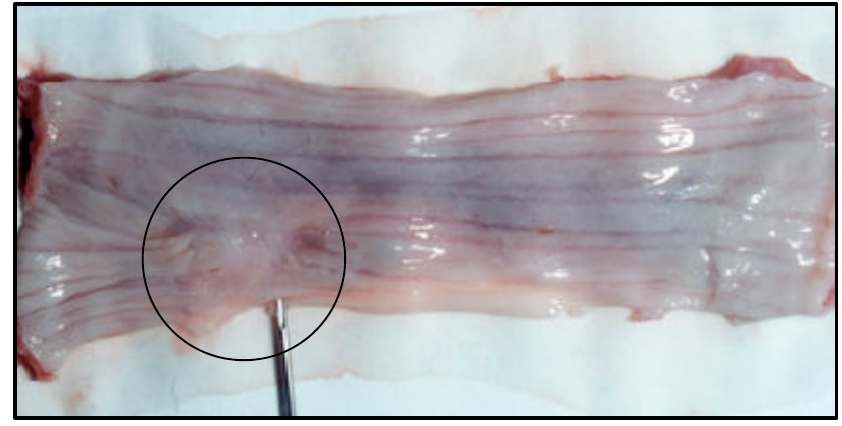
FIGURA 6 - Sítio de implante: aspecto macroscópico da peça cirúrgica aos 60 dias. O estudo anátomo-patológico pela coloração HE revelou reepitelização total da mucosa em 66% dos cães e parcial (80% de reepitelização) em 44% (Figura 7). A incorporação do enxerto foi completa em 75% dos casos. Quanto a proliferação fibroblástica (fibrose), esta foi intensa em 75% dos cães e moderada nos demais 25%. Em relação à proliferação neovascular, esta foi moderada em 66% dos casos e, discreta, em 44%. A resposta inflamatória aguda foi ausente na maioria dos cães (66%); discreta em 25% (média de